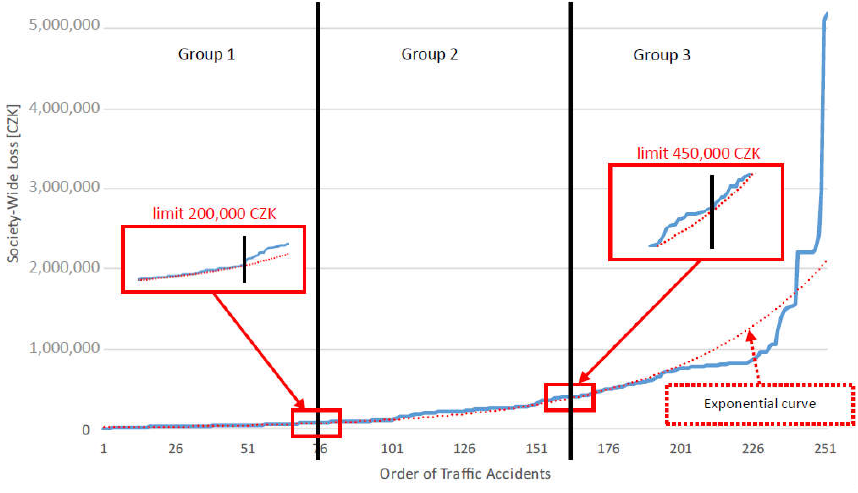
Figure 4. Distribution of Society-Wide Loss [CZK] for correlated traffic accident records.